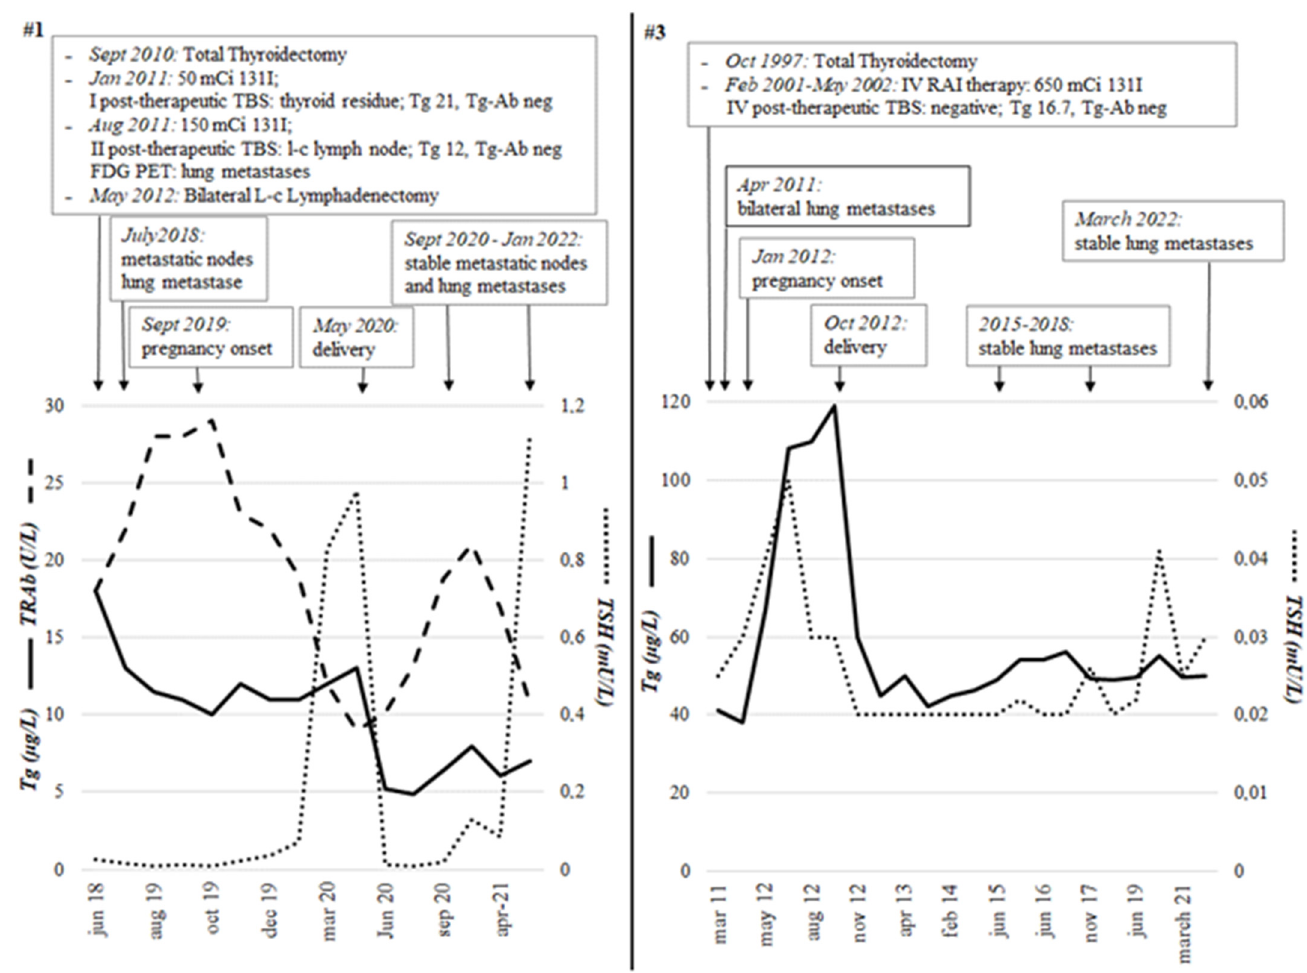
Figure 1. The two patients (#1 and #3) with papillary thyroid carcinoma and distant metastases at the time of pregnancy onset. The trend of Tg, TSH, and TRAb from the initial treatment (thyroidectomy and radiometabolic therapy) to the last follow-up visit, including pregnancy and postpartum period, is shown. Both patients had negative anti-thyroglobulin auto-antibodies. Both patients had no structural disease progression during or after pregnancy. Tg, Thyroglobulin; TSH, thyroid-stimulating hormone; TRAb, TSH receptor auto-antibodies; TBS, Total Body Scintigraphy; mCi, millicurie; RAI, Radioactive iodine.